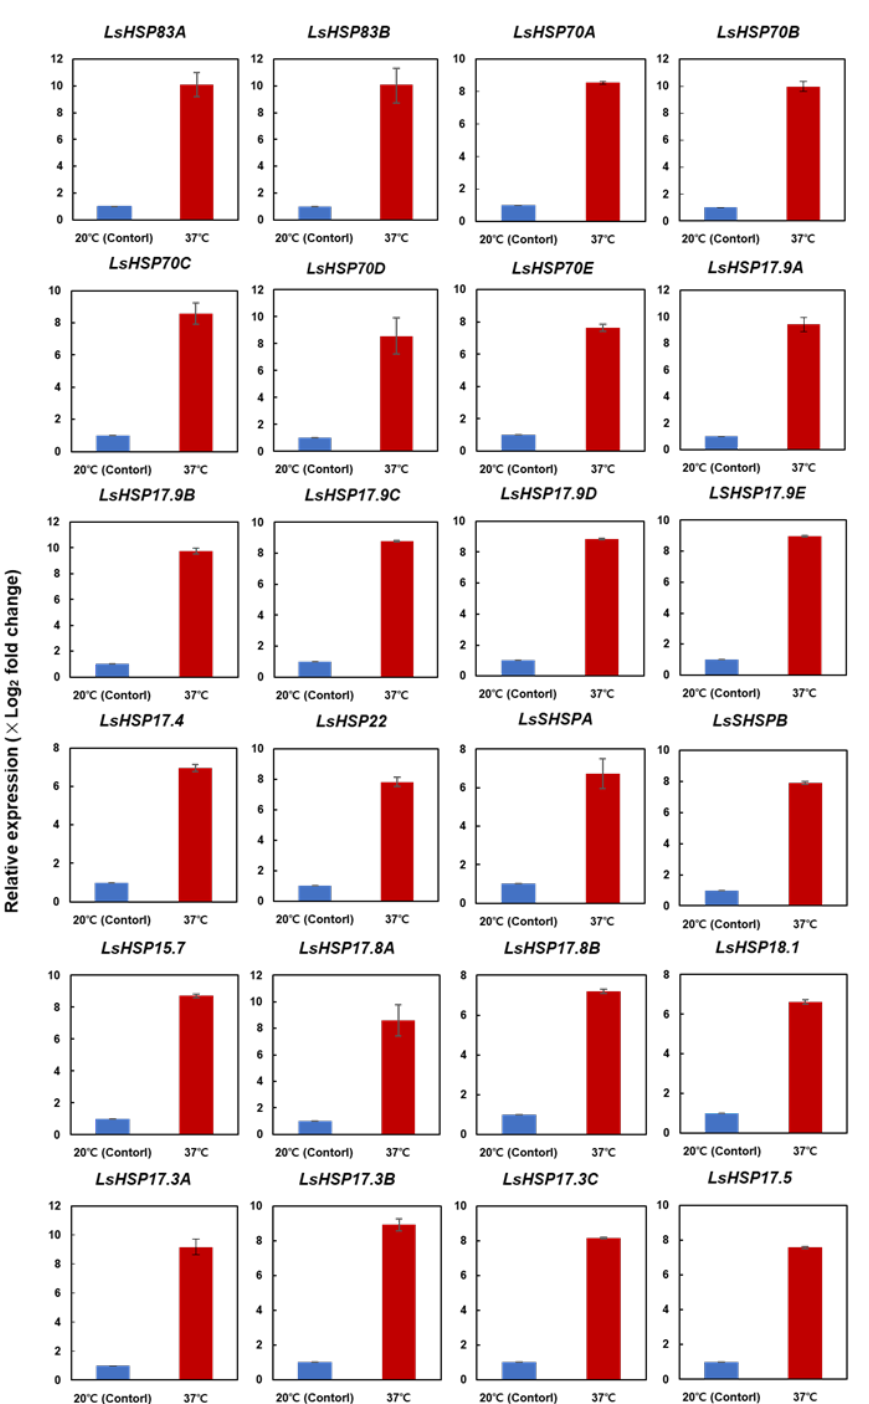
Figure 3. Validation of expression levels of selected lettuce heat shock protein genes. Validation of the heat-induced alterations in the expression of 24 LsHSP genes detected by transcriptome sequencing was carried out by qRT-PCR ( p < 0.05, Student’s t test). The x -axis represents temperature and the y -axis represents relative transcript level ( × Log 2 fold change). Each bar represents mean ± SE of three independent experiments.